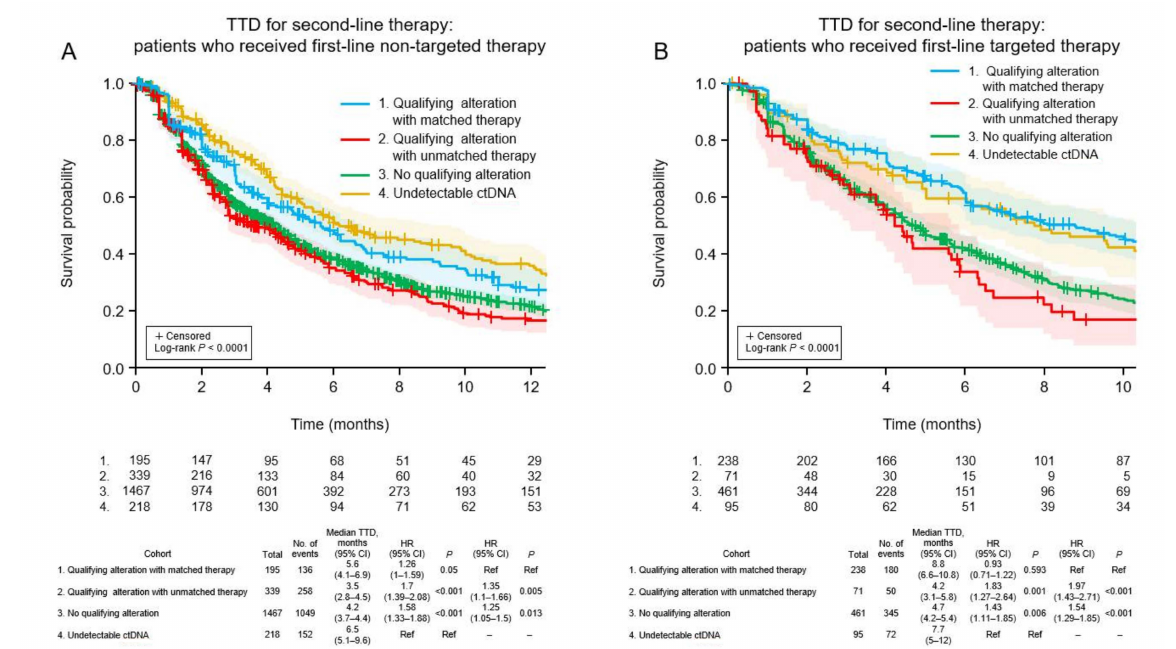
Figure 3. Time to discontinuation of second-line treatment in the four patient cohorts according to whether the first-line therapy was non-targeted ( A ) or targeted ( B ). CI, confidence interval; HR, hazard ratio; TTD, time to treatment discontinuation; Ref, reference.